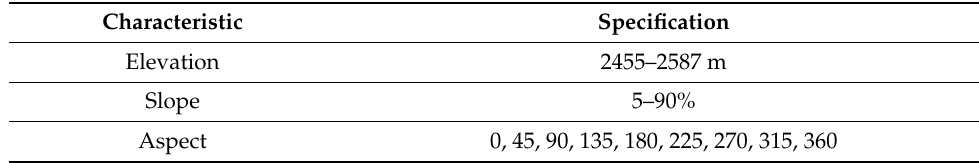
Table A2. Information used to build the test cases.